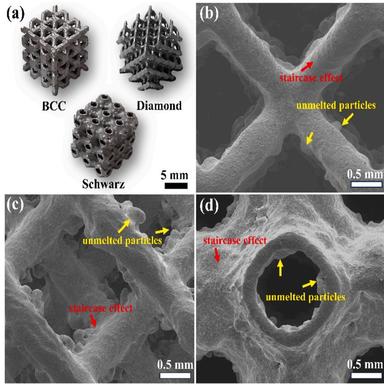
The appearance of the three lattice structures, (a) macroscopic morphology, and SEM image of (b) BCC, (c) Diamond, and (d) Schwarz.